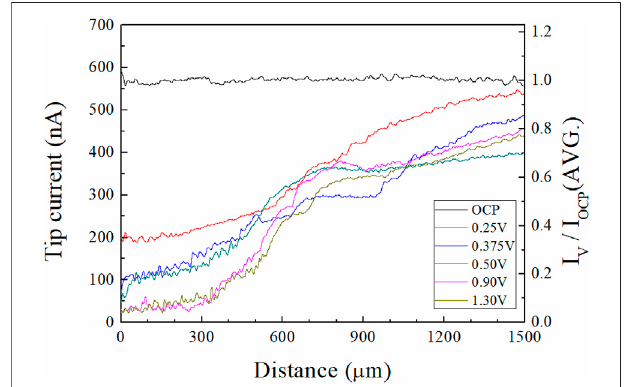
FIGURE 7 | Pro fi les of water electrolysis currents measured by SECM in 85% phosphoric acid (left) tip currents, and (right) I V /I OCP (AVG.) along the tip distance from the Cu substrate. I V and I OCP mean the tip currents at the applied potential “ V ” and OCP of the Cu substrate. The measurement system was illustrated in Figure 2